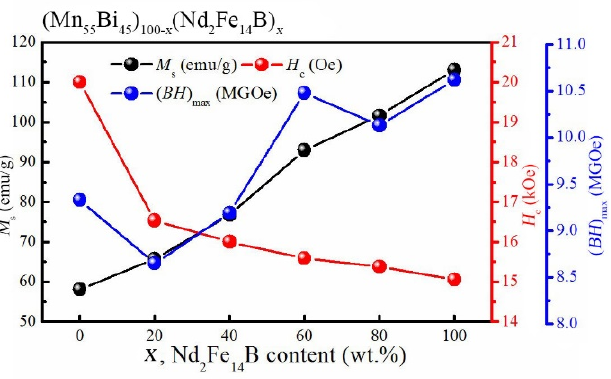
Figure 8. The variation curves of saturation magnetization ( M s ), coercivity ( H c ) and maximum energy product ( BH ) max of the bulk (Mn 55 Bi 45 ) 100 − x /(Nd 2 Fe 14 B) x ( x = 0, 20, 40, 60, 80, and 100) hybrid magnetic alloys at 350 K with the increase of Nd 2 Fe 14 B content. Table 3. The magnetic properties of the bulk (Mn 55 Bi 45 ) 100 − x /(Nd 2 Fe 14 B) x hybrid magnetic alloys at 350 K.